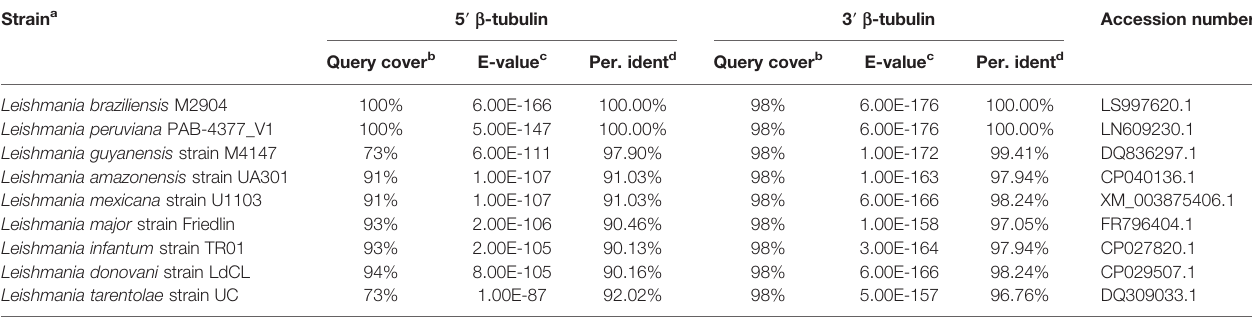
TABLE 1 | In silico basic local alignment of Leishmania braziliensis 5 ′ and 3 ′ b -tubulin sequences cloned in pTB007_Viannia. Strain a 5 ′ b -tubulin 3 ′ b -tubulin